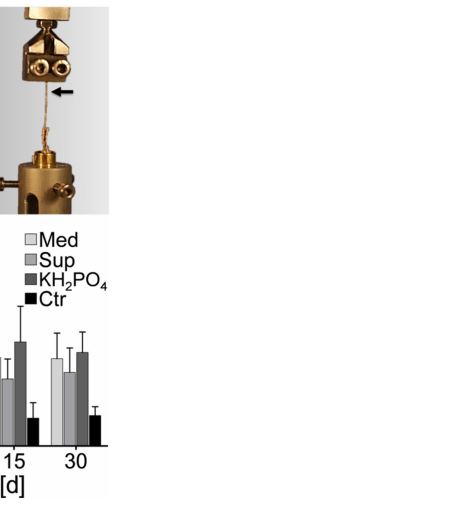
Figure 8. After insertion into the medullary cavity of sterile murine tibia bones and incubation in Figure 8. ( A ) The Mg pins were inserted into the medullary cavity of sterile murine tibia bones and different corrosion solutions at 37 °C at 5% CO 2 , the Mg pins exhibited an increased pull-out re- sistance in the absence of live cells. Abbreviations are as follows: Med, group incubated in freshly incu-bated in different corrosion solutions at 37 ◦ C and 5% CO2; ( B ) After incubation, the pull out